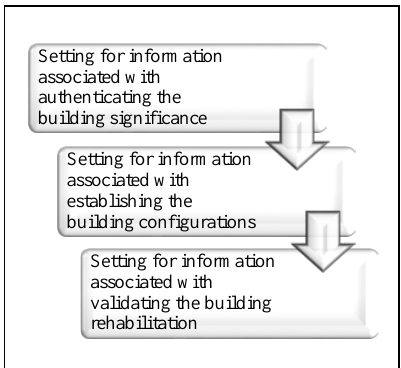
Figure 1. Information flow settings